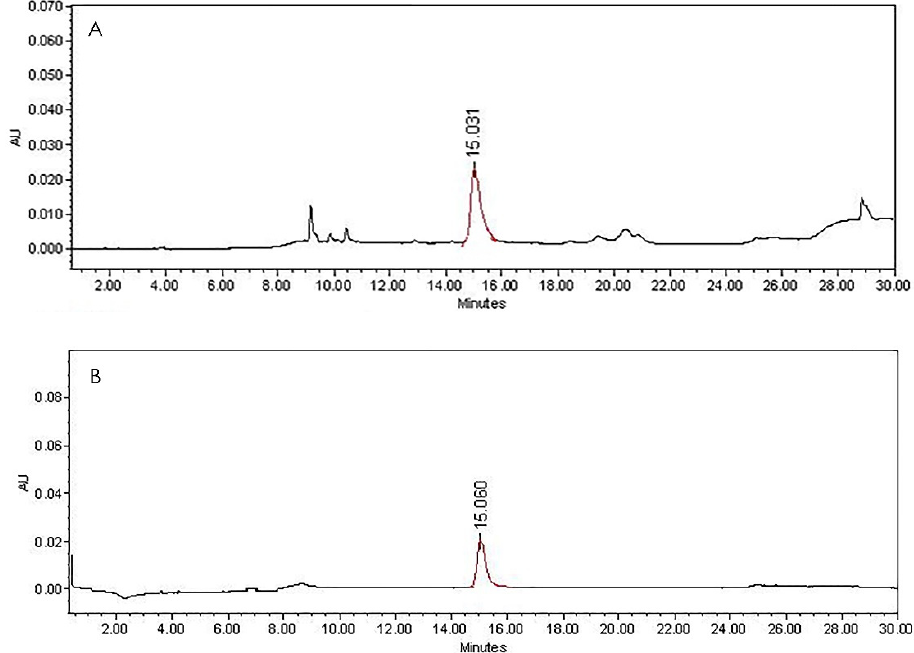
Figure 1. HPLC chromatogram of the ( A ) F8AC fraction and ( B ) Luteolin analytical